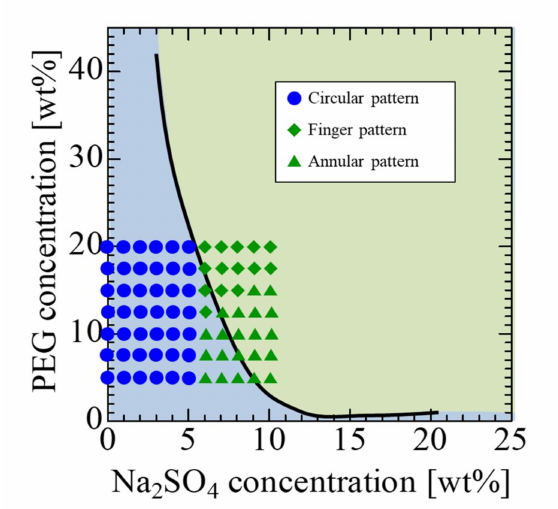
Figure 8. Phase diagram of the displacement patterns.